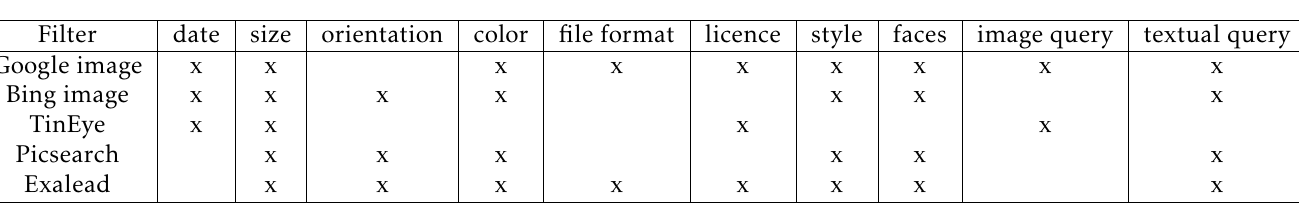
Table 1. Comparison of common filters proposed by image search engines